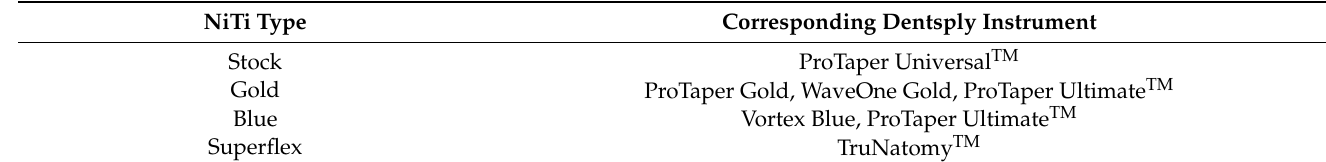
Table 1. List of NiTi wire types with their corresponding rotary instruments (all by Dentsply Maillefer, Ballaigues, Switzerland).